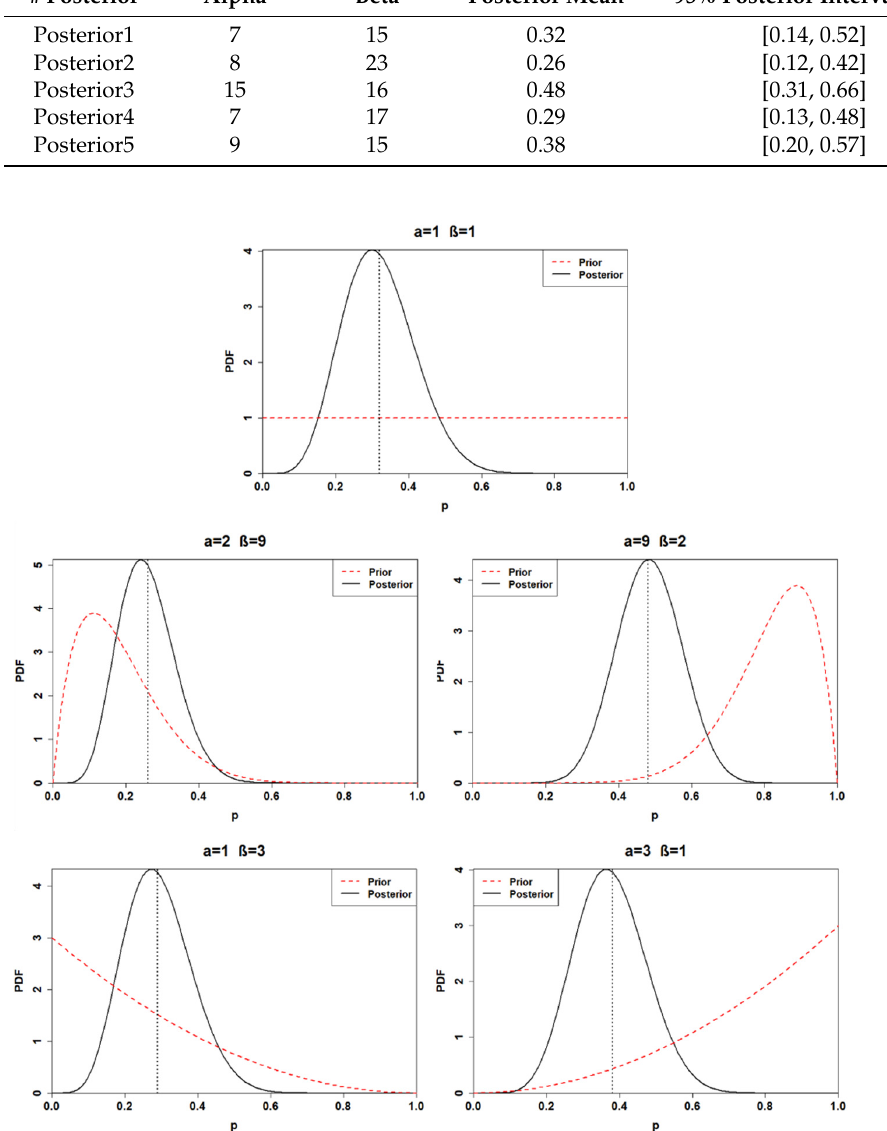
Figure 2. Posterior distributions of the second application (sample with n = 20, k = 6) for distinct choices of prior. The black dashed lines represent the posterior mean values.